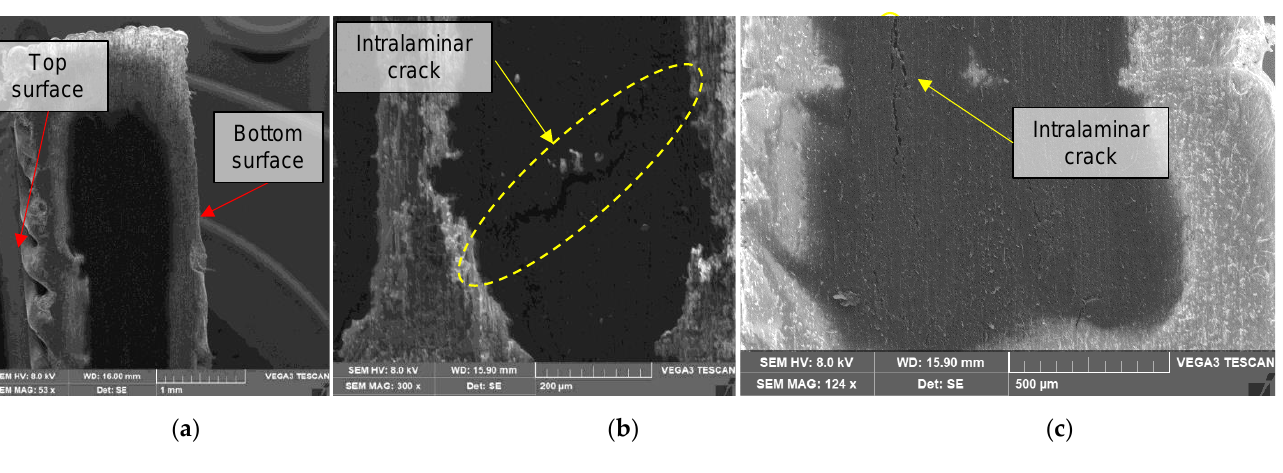
Figure 12. SEM transversal cut of a 55/110 layers carbon fiber on-edge printed sample: ( a ) 31 × , ( b ) 201 × .